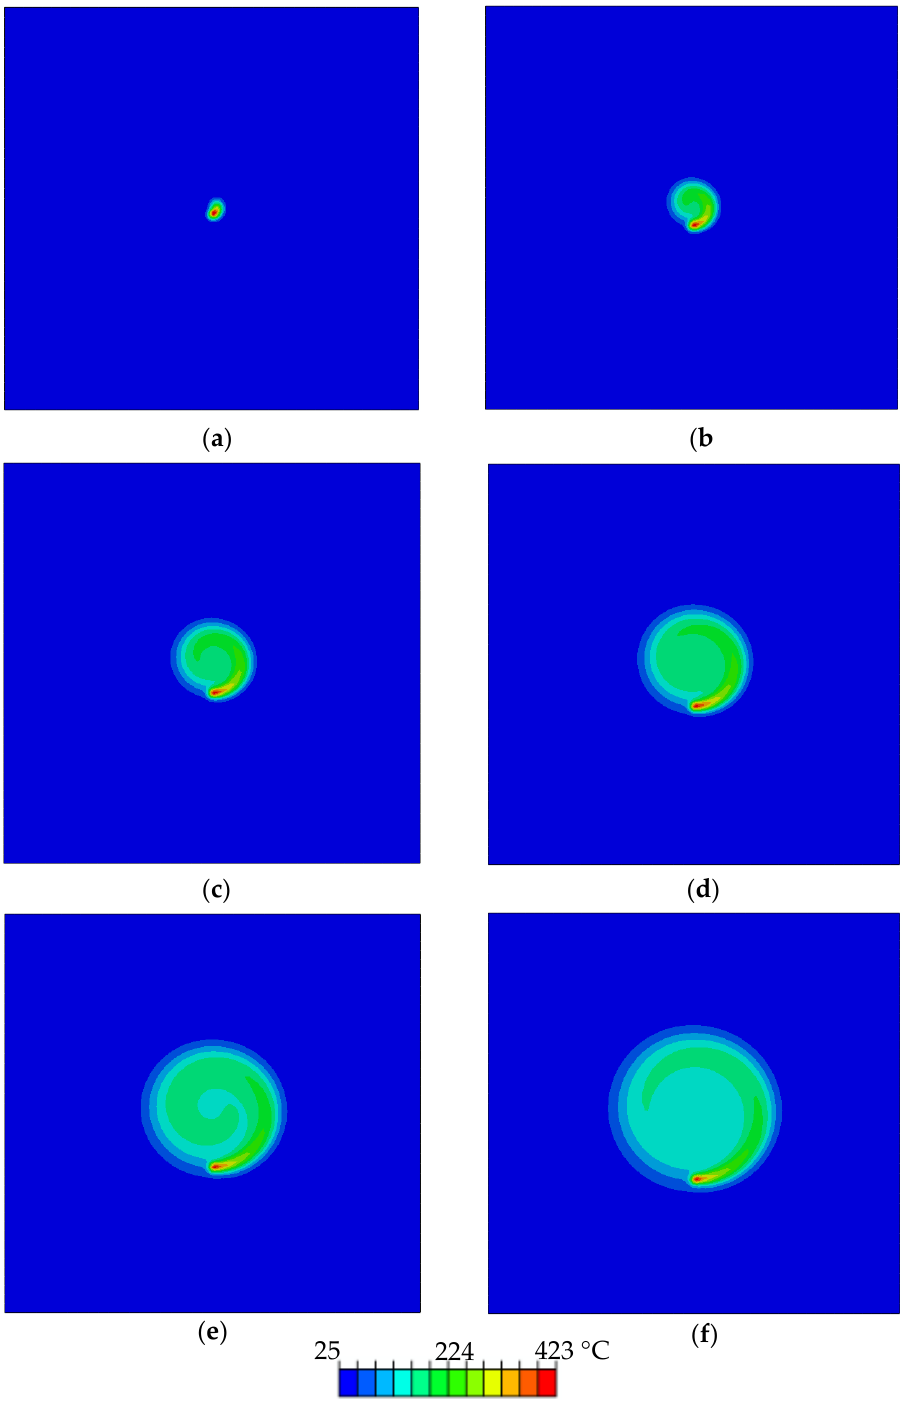
Figure 26. Temperature distribution at different time increments for melt pool of yellow color: ( a ) 0.14 s, ( b ) 0.85 s, ( c ) 2.14 s, ( d ) 3.9 s, ( e ) 6.42 s, and ( f ) 9.42 s.